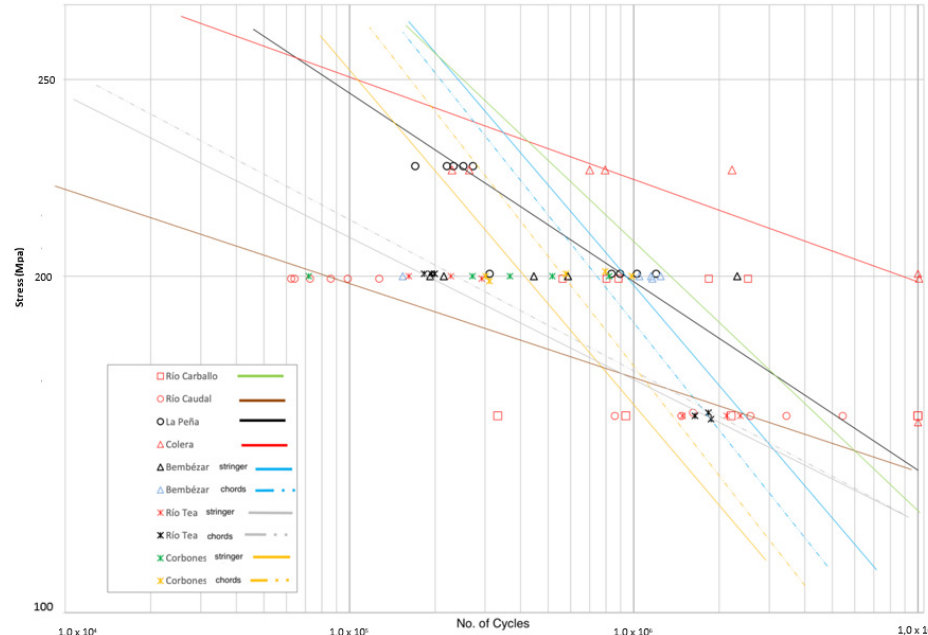
Figure 18. Summary of results. Stress (MPa) vs. No. of cycles for double-notched uniaxial fatigue tests (frequency: 10 Hz, R: 0.1)